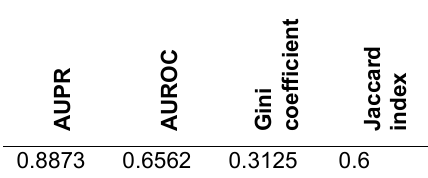
Table 7. Evaluation measures obtained for DBN